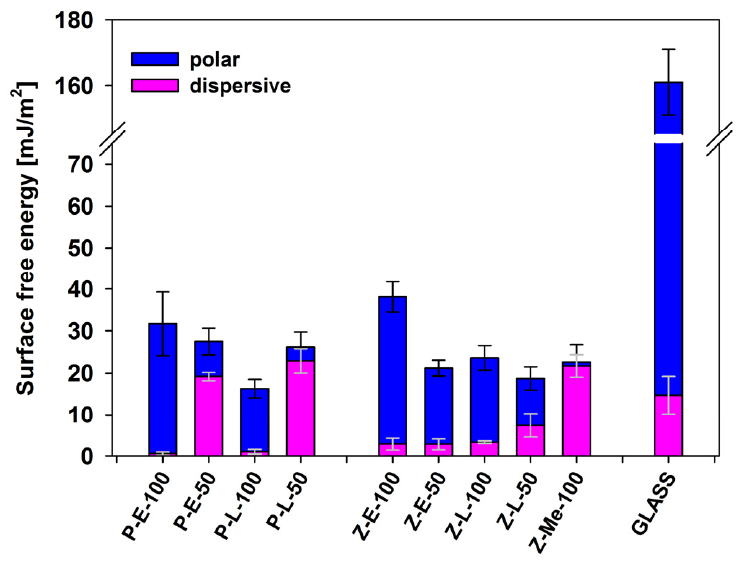
Figure 7. Surface free energy of functionalized polysiloxanes and sol-derived surfaces in comparison to the bare glass support (data presented as the mean ± standard deviation (SD, n = 4)).